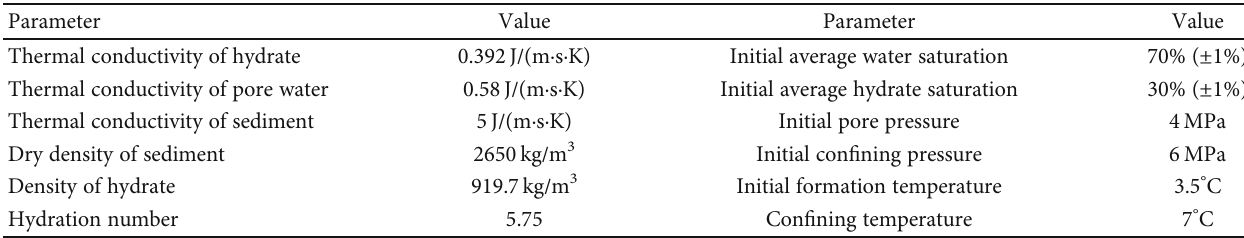
Figure 3: Comparison between the numerical results and experimental results for one-step quick depressurization. (a) The gas production rate and cumulative gas production evolution behaviors with time. (b) The pressure evolutionary behaviors at di ff erent locations in the HBS. The dash lines represent experimental results, while the solid lines represent numerical results. Table 1: Basic parameters for numerical